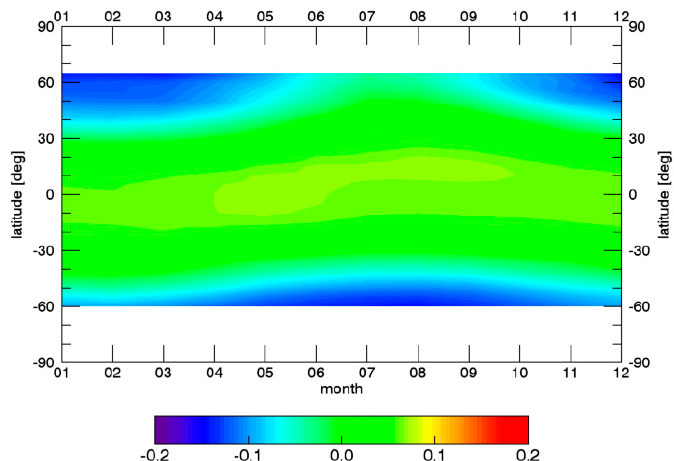
surface TB) between the two absorption models as function of time and latitude.